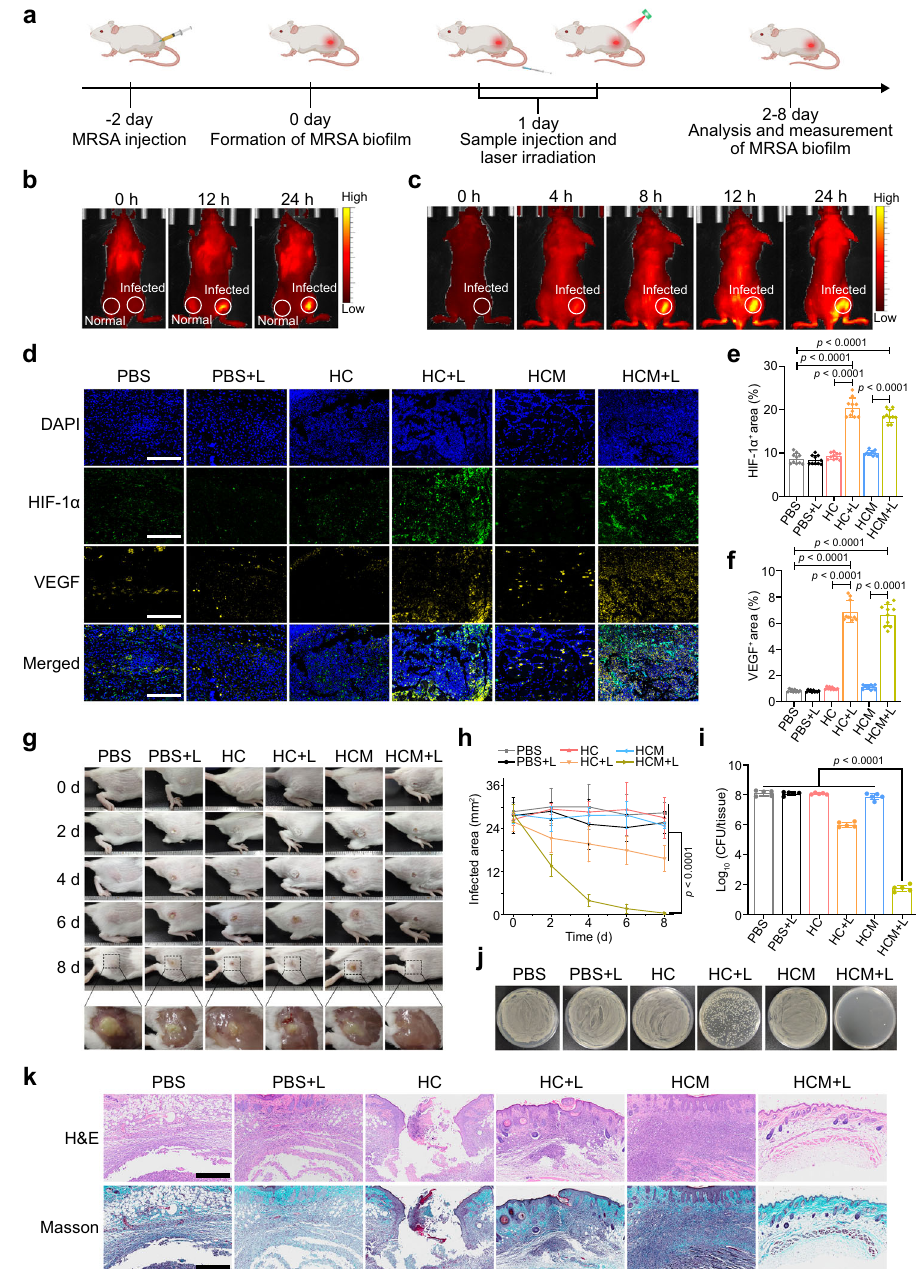
Fig. 5 Treatment of subcutaneous MRSA bio fi lm infected mice by HCM NPs. a Schematic illustration of the experimental procedure for treating MRSA bio fi lm infected mice. b Fluorescence images of MRSA bio fi lm infected mice after in situ injection of HCM NPs (Ce6: 100 μ g/mL, 50 μ L) in normal tissues (left side of thigh) and bio fi lm infected tissues (right side of thigh), respectively. c Fluorescence images of MRSA bio fi lm infected mice after i.v . injection of HCM NPs (Ce6 = 4 mg/kg; MNZ = 2 mg/kg). d Representative immuno fl uorescence images of HIF-1 α (green) and VEGF (yellow) in MRSA bio fi lm infected tissues after various treatments for 4 d. Scale bar is 400 μ m. The percentage of HIF-1 α + ( e ) and VEGF + ( f ) area in various treatment groups calculated from the immuno fl uorescence images ( n = 10 biologically independent samples; mean ± SD). Photographs of the infected tissues ( g ) and infected area ( h ) of the mice after various treatments ( n = 5 biologically independent samples; mean ± SD). i Quanti fi cation of viable bacteria inside bio fi lm-infected tissues at 8 d post-treatment ( n = 5 biologically independent samples; mean ± SD). j Photographs of MRSA colonies from infected tissues at 8 d post-treatment. k H&E and Masson ’ s trichrome stained slices of the infected tissues from mice at 8th d post-treatment. Scale bar is 500 μ m. Statistical signi fi cance was analyzed via one-way ANOVA with a Tukey post-hoc test. Source data are provided as a Source Data fi le. group (4.9 log, 99.999%), and HC + L group (6.7 log, 99.99997%) reveal that the M1-like macrophages decreased and the M2-like (Fig. 8d and Supplementary Fig. 19). macrophages increased in HCM + L group (Fig. 8e – g), suggesting The overexpression of HIF-1 α in HCM + L group indicates macrophage polarization to the M2-like phenotype in infected that PDT can exacerbate hypoxia level of the bio fi lm-infected wounds. The decreased secretion of TNF- α and IL-12p70, and the tissues (Supplementary Fig. 20). The immuno fl uorescence images increased secretion of Arg-1 and IL-4 in HCM + L group further NATURE COMMUNICATIONS| (2022) 13:3875